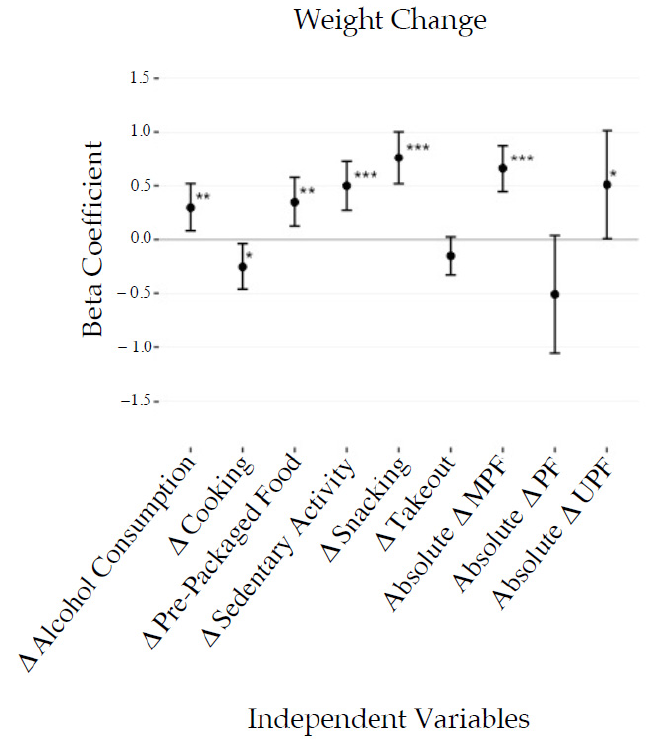
Figure 4. Combined stepwise linear regression outputs presenting the relationships between behavioral, demographic, and anthropometric factors to change in weight in kilograms. This analysis was conducted in six separate models for each type of calorie, separating factors into either demographic/anthropometric factors or behavioral factors. Changes in alcohol consumption, sedentary activity, cooking, takeout food consumption, baseline exercise, and ready-to-eat packaged food consumption were included in the behavioral model, while the remaining variables were included in the demographic/anthropometric model. Factors dropped from models are not shown. Results are presented as beta coefficients in kg with 95% confidence intervals. * p < 0.05, ** p < 0.01, *** p < 0.001.